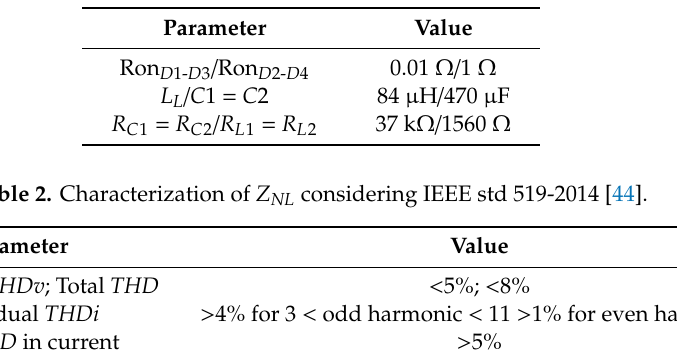
Figure 2. Nonlinear load Z NL , consisting of an unbalanced diode-bridge rectifier that supplies to an R–C load, based on Reference [35]. Table 1. Parameters for Z NL .